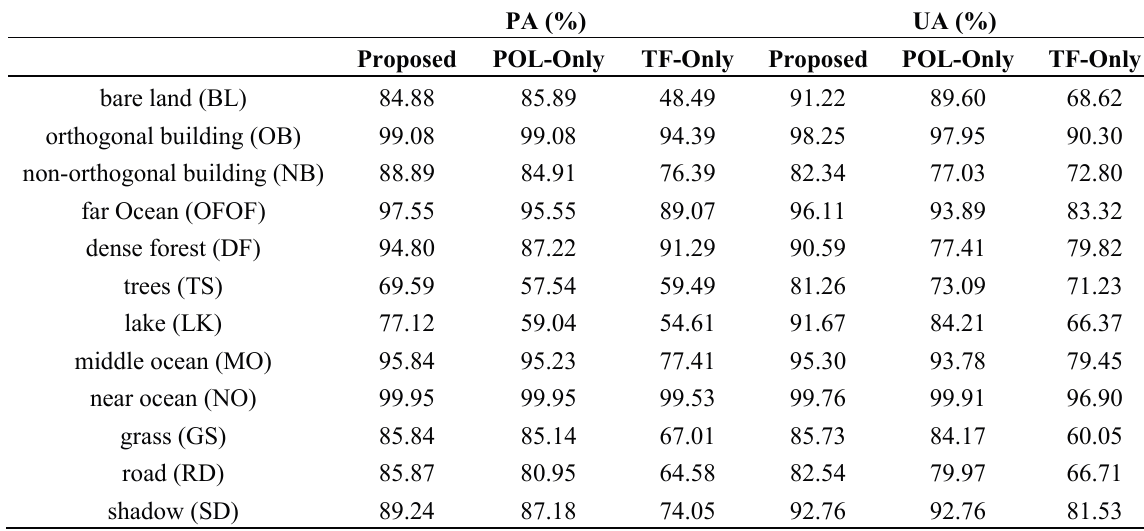
Table 7. PA and UA of POL-only and TF-only method on L-band.